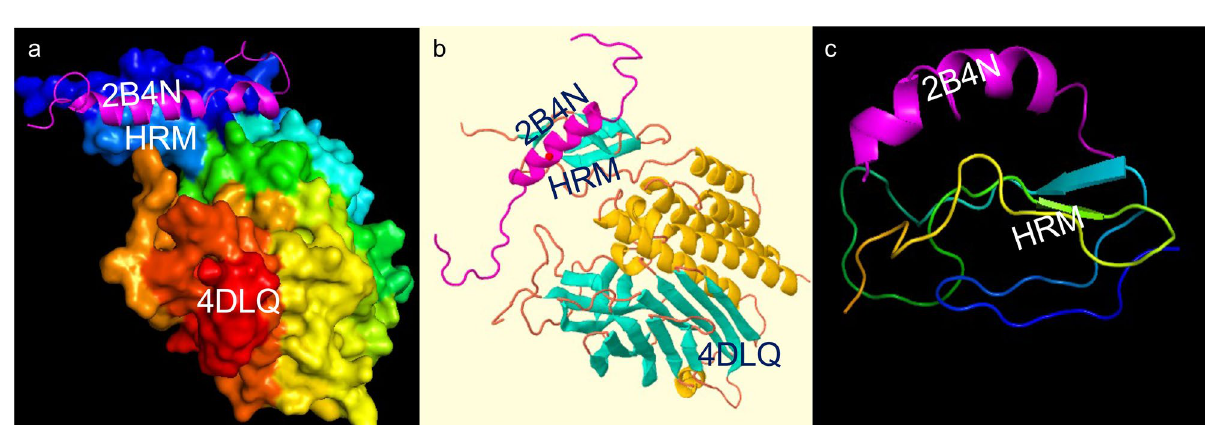
Figure 5. Results of protein–protein docking via ( a ) ClusPro, ( b ) FRODOCK, and ( c ) KBDOCK. Here, 4DLQ (HRM domain) and 2B4N are shown in navy blue in magenta, respectively. Note the reproducibility of the protein–protein docking results between these two